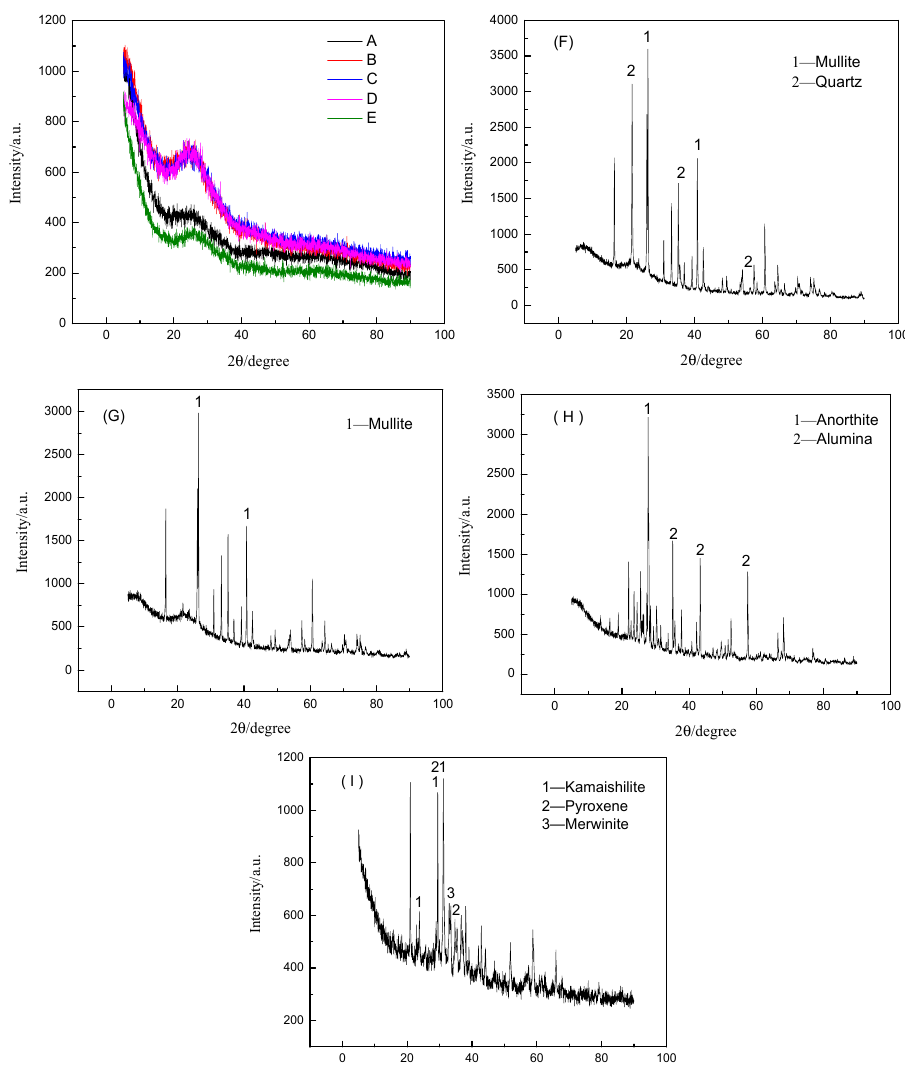
Figure 7. X-ray diffraction patterns of imitation basalt compounds and raw materials after treatment at 1500 °C: ( A ) red mud imitation basalt compound; ( B ) fly ash 1 imitation basalt compound; ( C ) fly ash 2 imitation basalt compound; ( D ) coal gangue imitation basalt compound; ( E ) basalt; ( F ) coal gangue; ( G ) fly ash 2; ( H ) fly ash 1; ( I ) red mud.